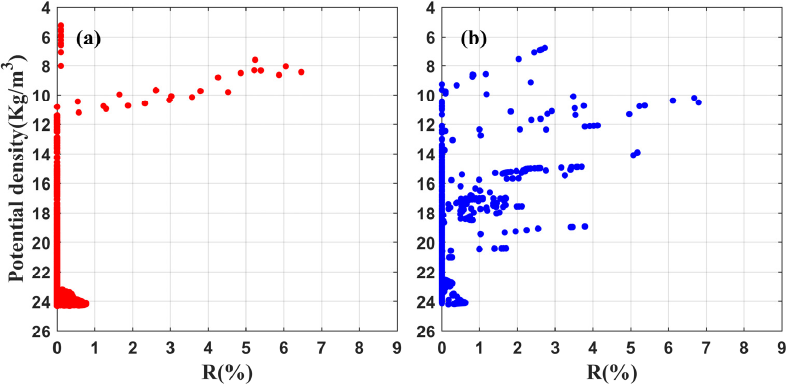
Figure 3. Plots of the calculated mass balance residuals against the potential density for the April ( a ) and May cruises ( b ).